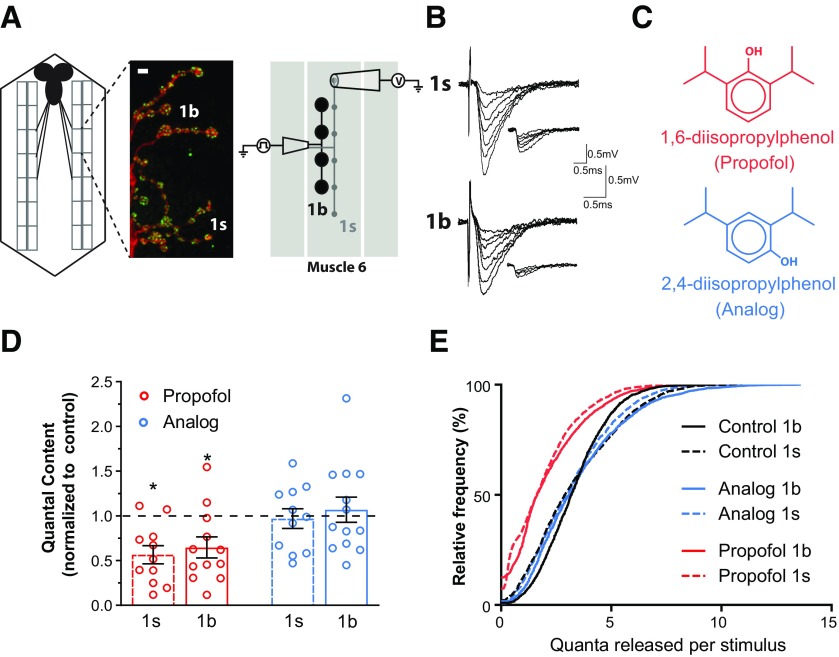
Propofol decreases glutamate release similarly from different synapse types. A, Left, Schema of Drosophila larval NMJ preparation. The black structure is the brain, rectangles are muscle segments. Middle, Muscle 6 motor nerve terminals labeled with HRP to identify neurons and nc82 to identify active zones. 1s and 1b boutons are indicated. Scale bar, 4 μm. Right, Diagram illustrating the configuration for focal macropatch recording from single 1s and 1b boutons at the fly larval NMJ. B, Example traces of EJCs and mEJCs (inset) recorded from 1s and 1b boutons in the CS strain. C, Chemical structures of propofol (1,6-diisopropylphenol) and its nonanesthetic analog, 2,4-diisopropylphenol. D, Normalized QC in drug-treated preparations (3 μm) for both bouton types. Parameters were normalized to their respective averages in non-drug-treated controls (dashed line). Raw data are presented in Extended Data Figure 1-1. *p < 0.05; Student’s t test. Graphs show individual data points (animals), and error bars show the average ± SEM. E, Cumulative plot of quanta released per stimulus, for both bouton types and both drugs.